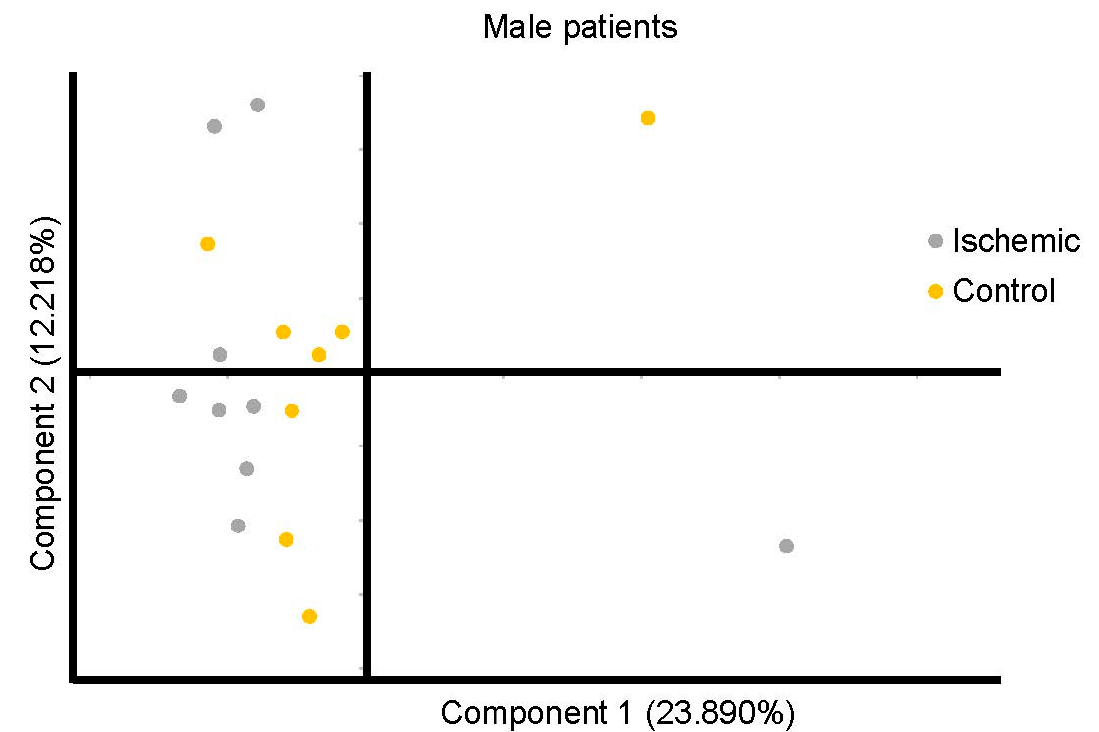
Figure 4. Principal Component Analysis for all metabolites in the male ischemic and control population. Component 1 is plotted on the × axis and Component 2 is plotted on the Y axis. Component 1 encompassed 23.890% of the variation between participants and Component 2 encompassed 12.218% of the variation between participants.